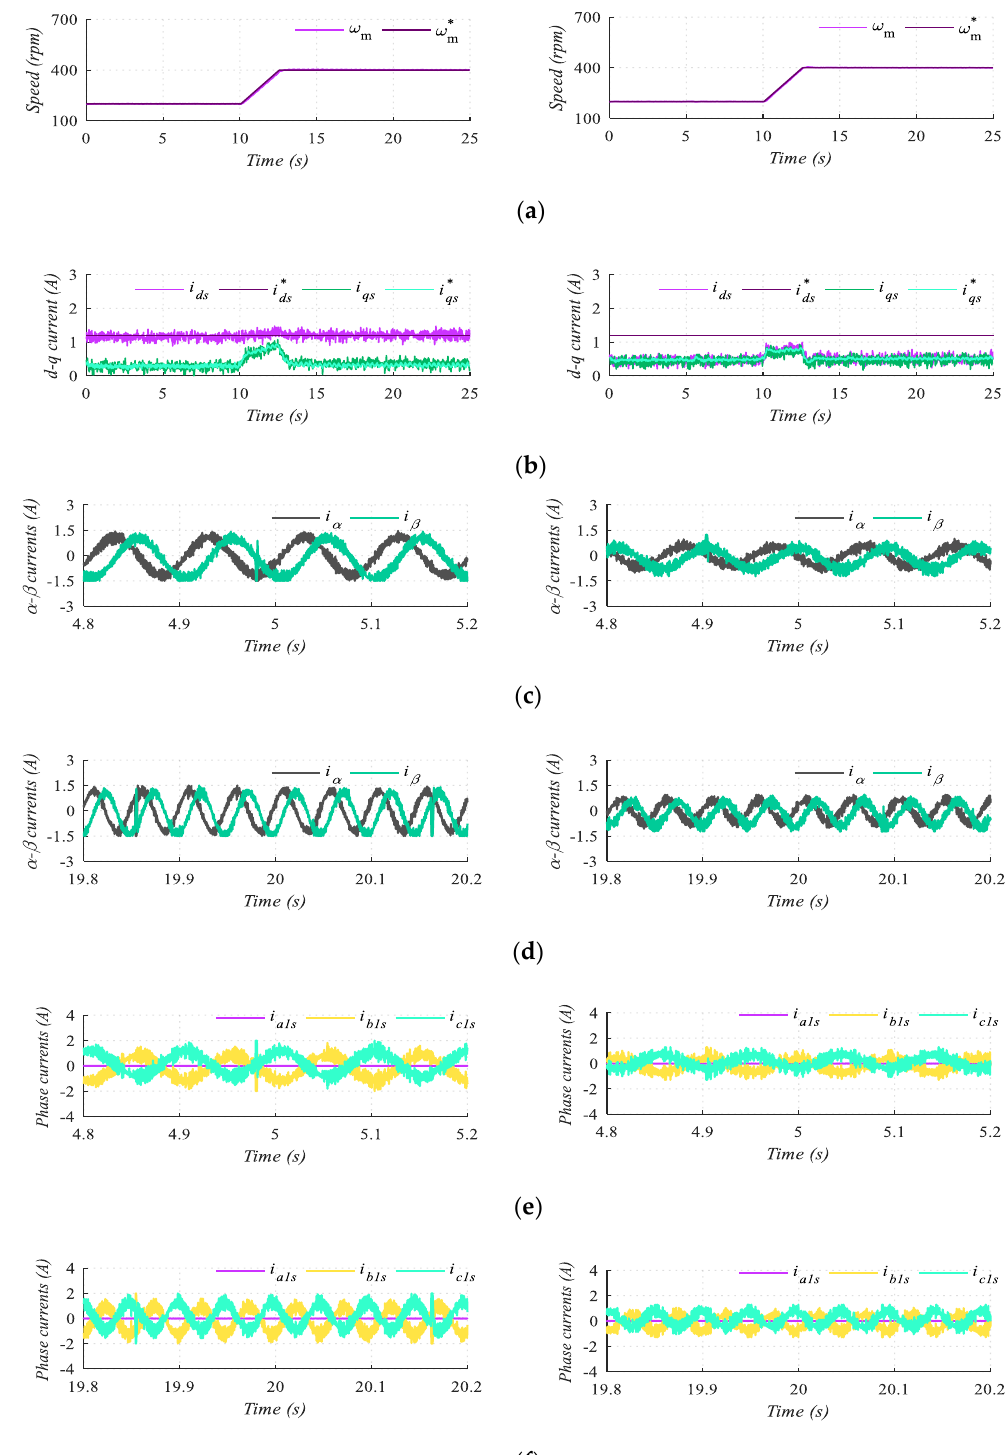
Figure 9. Post-fault dynamic response using VV-MPC technique (left column) and the proposed EVV-MPC method (right column). From top to bottom: ( a ) Motor speed; ( b ) d - q currents; ( c ) zoom 1 of α - β currents; ( d ) zoom 2 of α - β currents; ( e ) zoom 1 of set 1 of phase currents; and ( f ) zoom 2 of set 1 of phase currents.